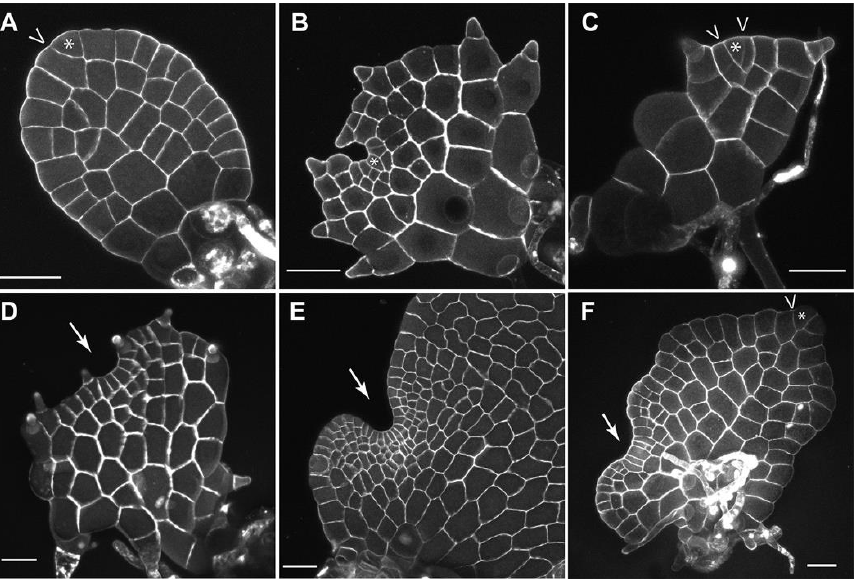
Figure 1. Confocal images of the three meristem types in fern gametophytes: apical cell-based ( A – C , F ), multicellular apical ( D ), and multicellular marginal ( E , F ). Asterisks and arrows indicate the wedge-shaped apical cells and multicellular meristems, respectively. “V” indicates the cell division in the apical cell ( A , C , F ). ( A , F ): Pteris vittata , ( B ): Sphenomeris chinensis , ( C , D ): Woodsia obtusa , ( E ): Ceratopteris richardii . Scale bar: 50 μm. Gray ( A – F ): cell wall stain.